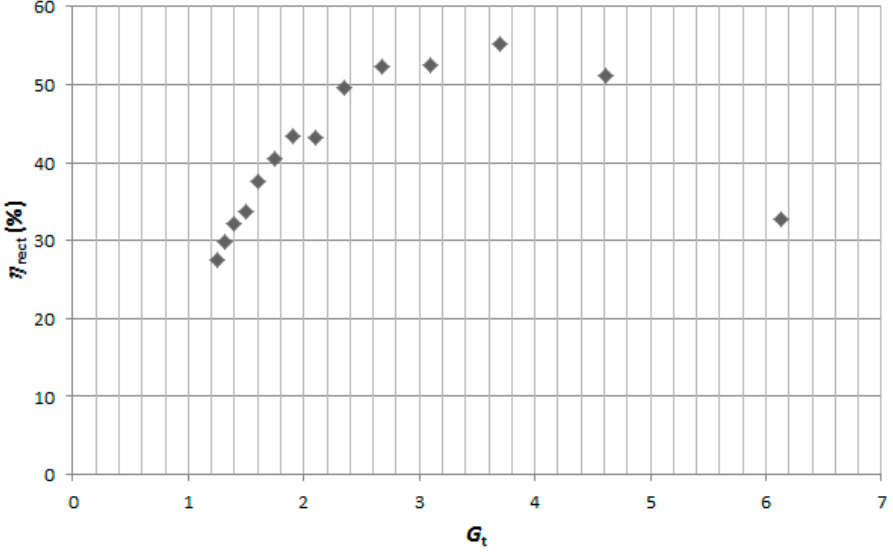
Figure 8. Simulation results of η rect for several values of G t at P av = − 10 dBm. A maximum value ( η max ) of 55.2% was achieved at G t = 3.7 ( C m = 0.5 pF).